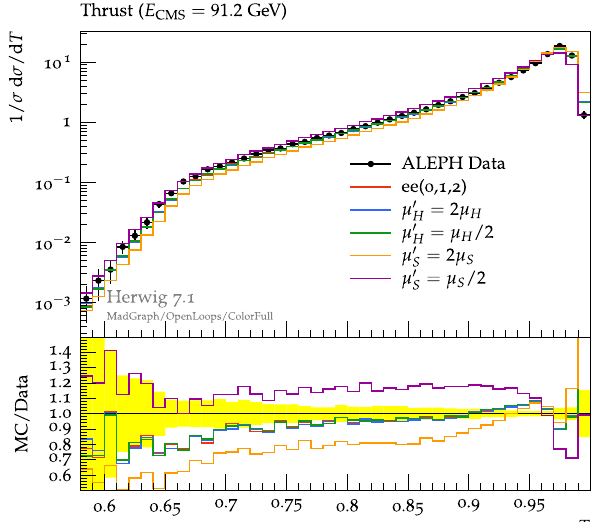
Fig. 14 Comparision of LO merging in a non-unitarized (blue), full unitarized and improved unitarized merging procedure. We choose a largecolliderenergyof100TeVtoempathisethebehaviouratthemerg- ing scale. The observable is the transverse momentum of the Z 0 -boson adds those in the PS-region to the underlying process con-